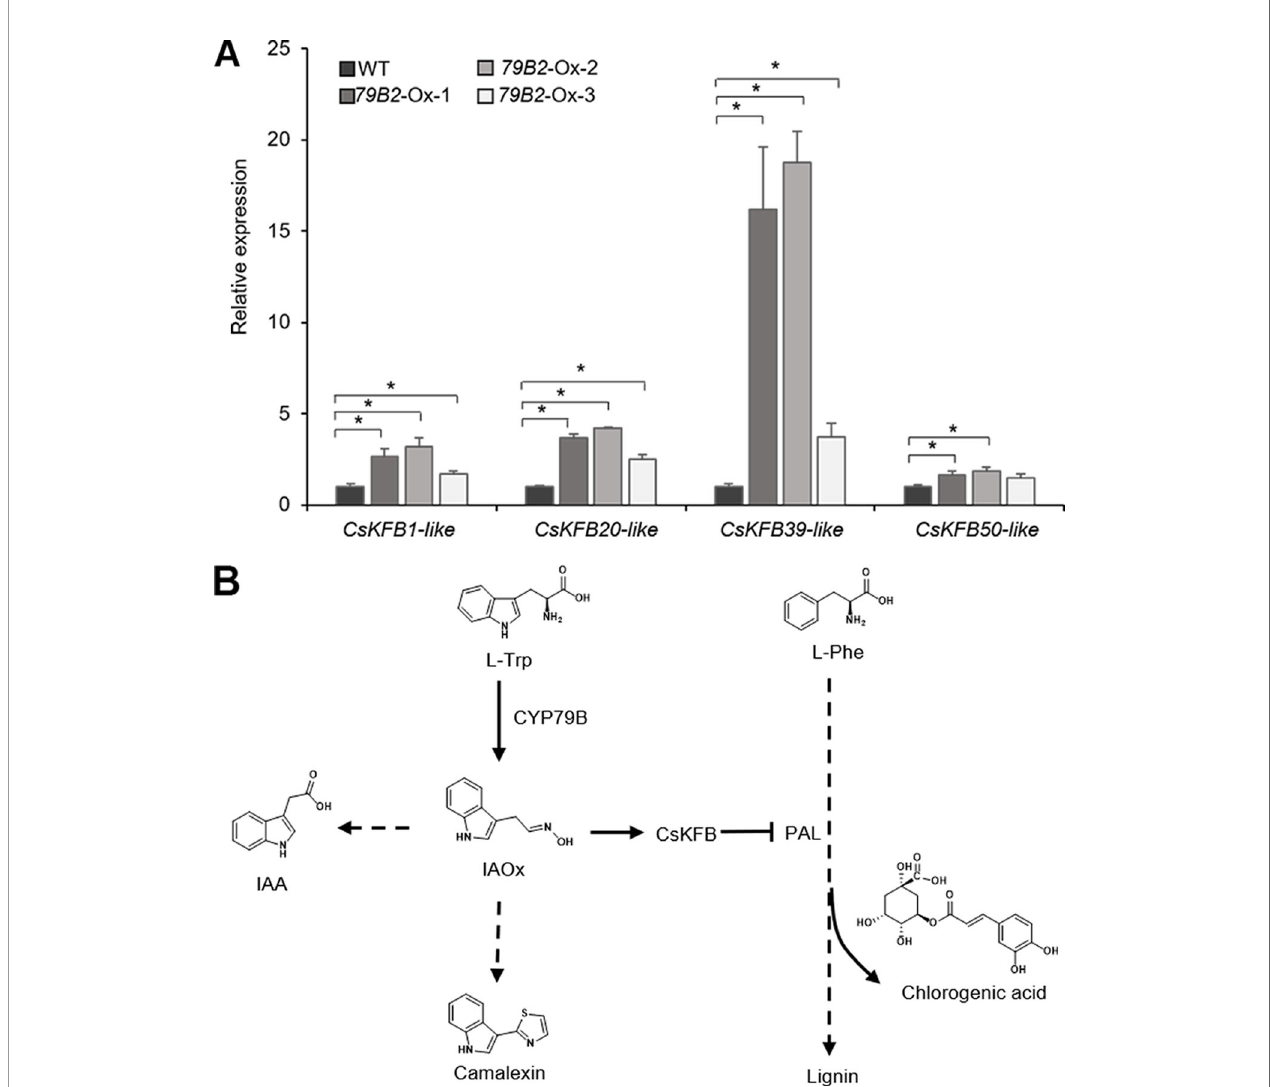
FIGURE 7 | Increased expression of CsKFBs in the Camelina transgenic plants and a proposed model showing a link between IAOx metabolism and the phenylpropanoid pathway in Camelina. (A) Transcript abundance of CsKFBs in Camelina transgenic lines overexpressing AtCYP79B2 . CsKFB1-like represents the expression of three KFB1 homolog genes ( Csa17g021220 , Csa03g019430 , Csa14g018700 ). CsKFB20-like represents two CsKFB20-like genes ( Csa09g09457 0, Csa07g059430 ). CsKFB39-like and CsKFB50-like represent three CsKFB39-like genes ( Csa06g050450 , Csa05g006160 , Csa04g061960 ) and three